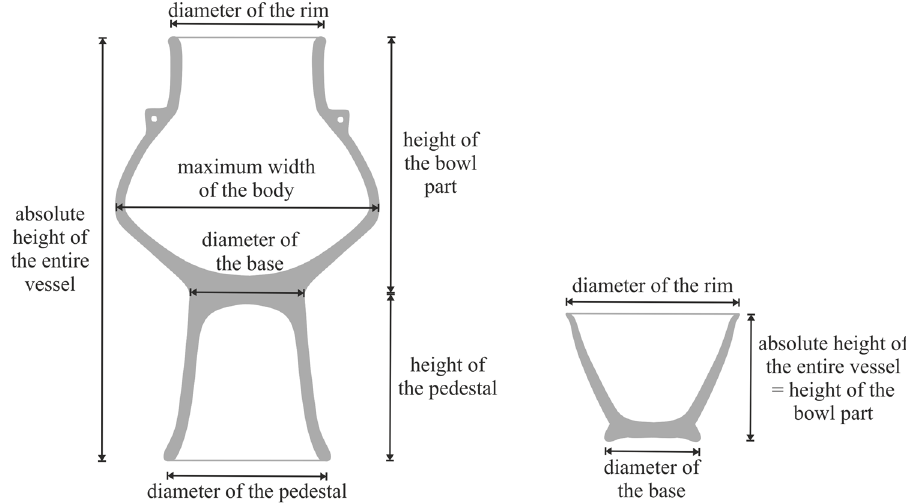
Figure 4: Metric data recorded on each